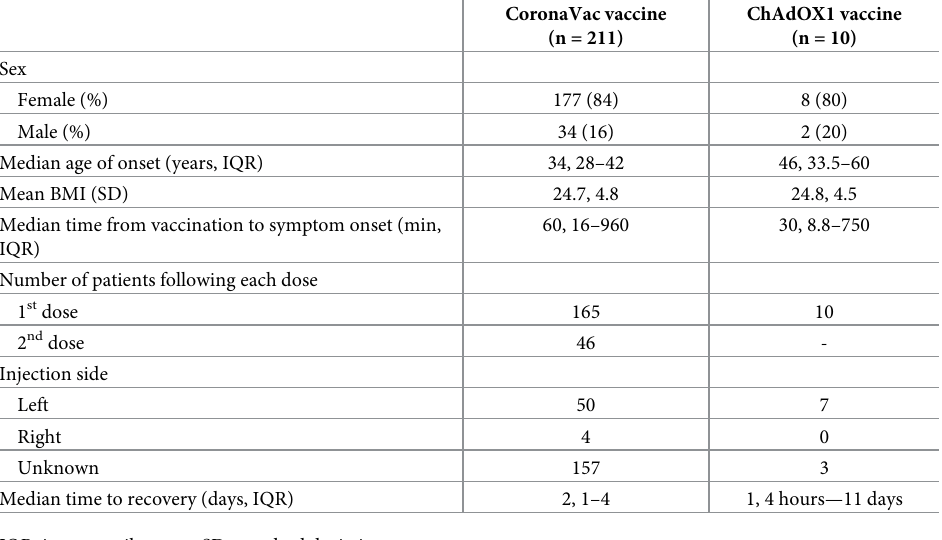
Table 1. Clinical and demographic data for immunization stress-related responses